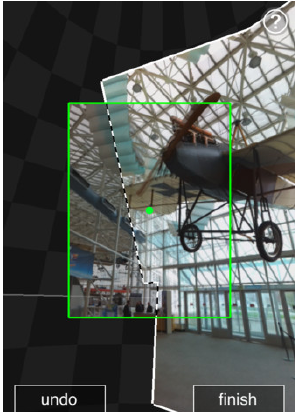
Figure 1: Microsoft PhotoSynth application for mobile devices as an example for an intuitive photogrammetric application for unexperienced users. The operator is asked to turn the viewing direction (green dot) out of the previously captured area (high- lighted polygon). When the dot reaches the dashed line, a new image is taken automatically, preserving enough overlap of the new image (green rectangle) with the others (white outline) for the post-processing image stitching. The user may take additional photos which then are merged to the automatically taken ones.